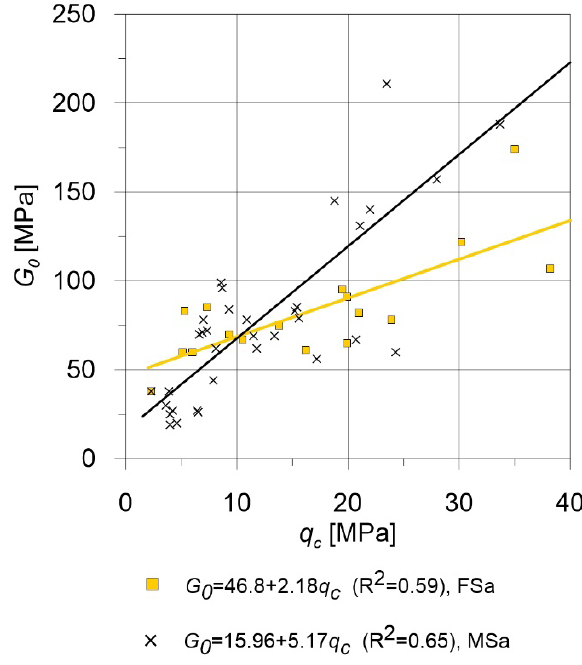
and cone resistance 0